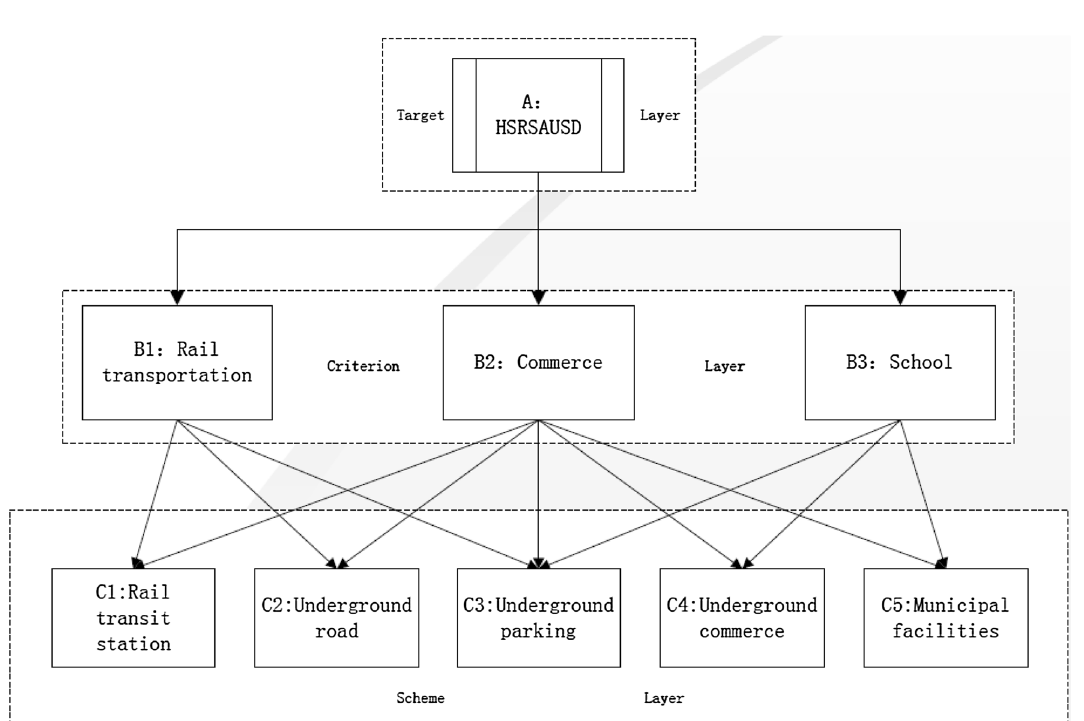
Fig. 7 The underground space development hierarchy of high-speed railway station